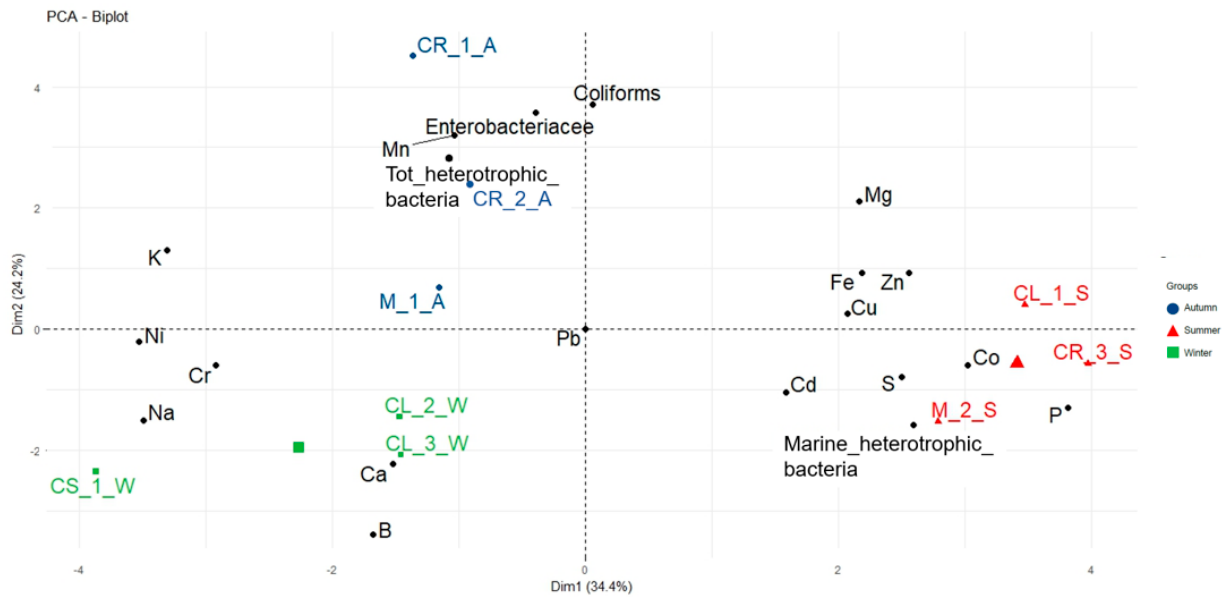
Figure 5. Principal component analysis of each fish species Chelon ramada (CR), Chelon labrosus (CL), Chelon saliens (CS), Mugil cephalus (MC) metal contents and Fulton’s condition index (K index) along the seasons Autumn II (A), Winter III (W), Summer V (S).